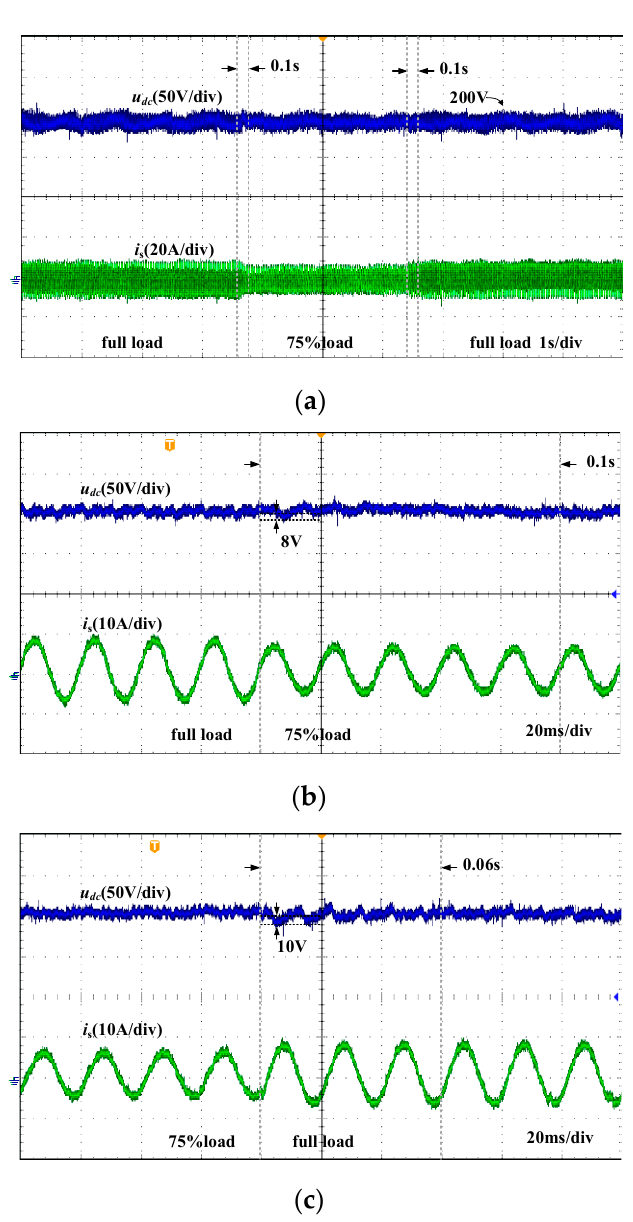
Figure 14. Experiment waveforms for load switching: ( a ) in scanning view; ( b ) in load reduction; and ( c ) in load increase.